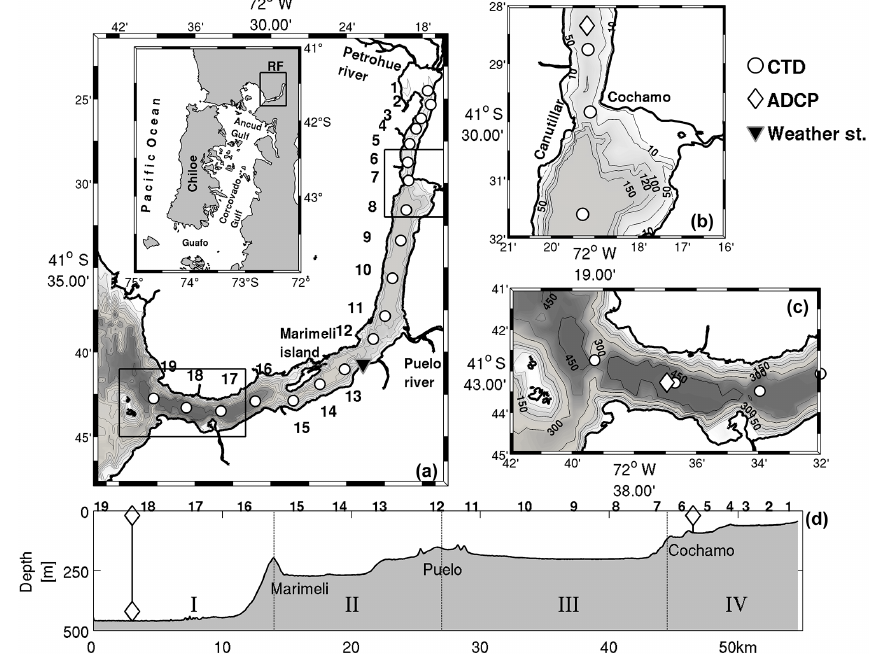
Figure 1. (a) The Reloncaví fjord region and location of the instruments. The upper left insert shows the general region. The ADCP moorings are near the mouth (ADCP). On the right, the insets show the (b) Cochamó and (c) mouth regions. The lower inset (d) shows the along-fjord bathymetry, in which the segmented lines indicate the sub-basin limits: mouth–Marimeli (I), Marimeli–Puelo (II), Puelo–Cochamó (III) and Cochamó–Petrohue (IV). The diamonds represent the location and depths of the ADCP mooring shown in panel (c)